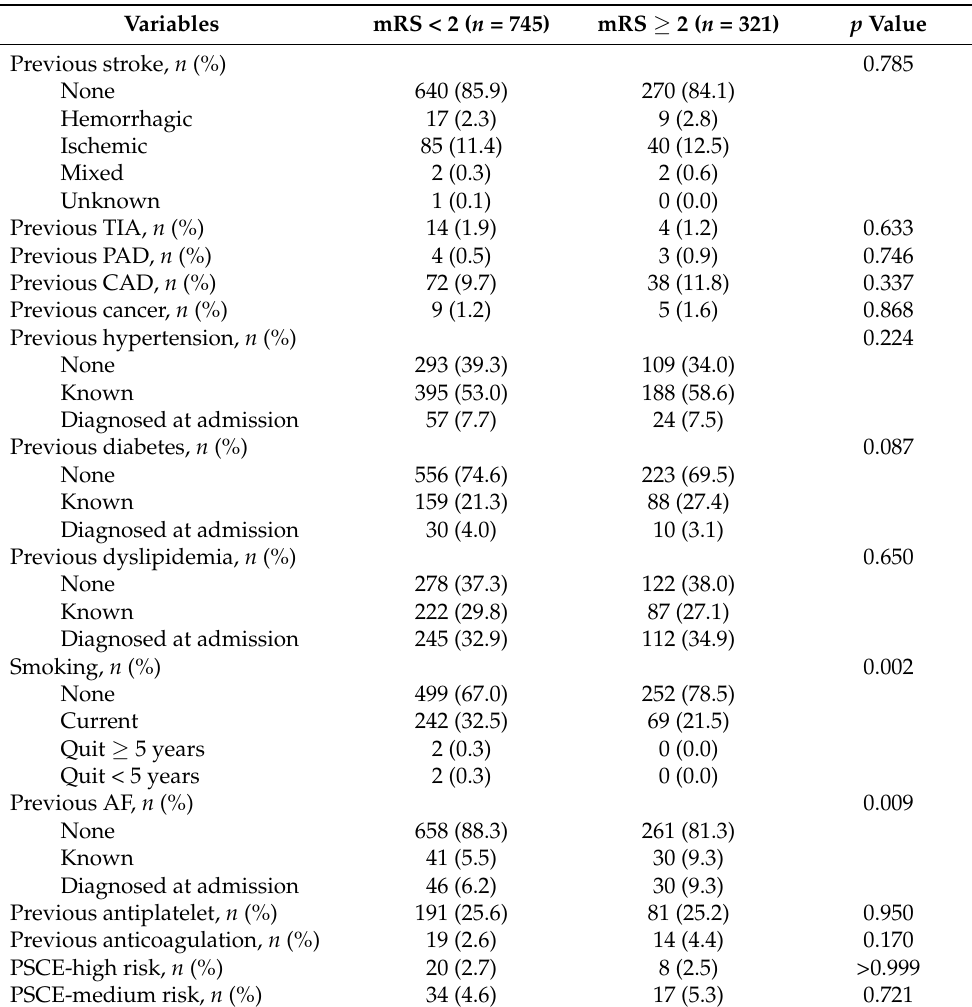
Table 2. Underlying risk factors in each